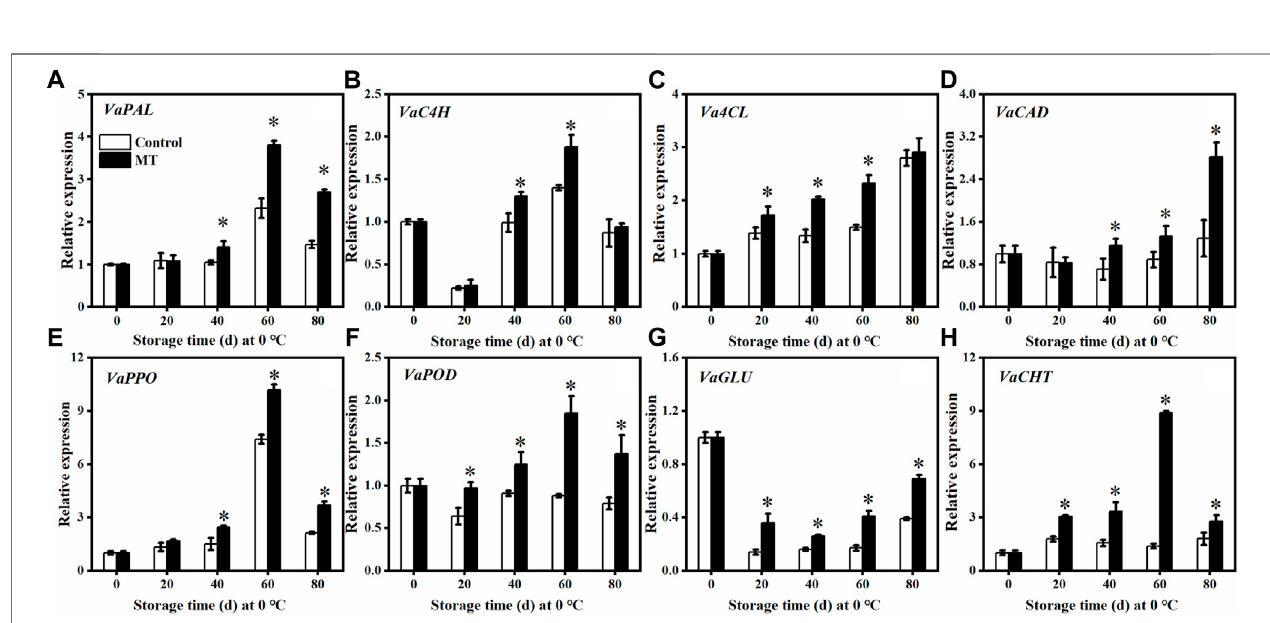
FIGURE4| EffectsofMTtreatmentonthegeneexpressionsof VaPAL (A) , VaC4H (B) , Va4CL (C) , VaCAD (D) , VaPPO (E) , VaPOD (F) , VaGLU (G) ,and VaCHT (H) during the postharvest storage at 0 ° C. Here, symbol * indicates signi fi cant differences ( p < 0.05). Data are presented as the mean ± SD.